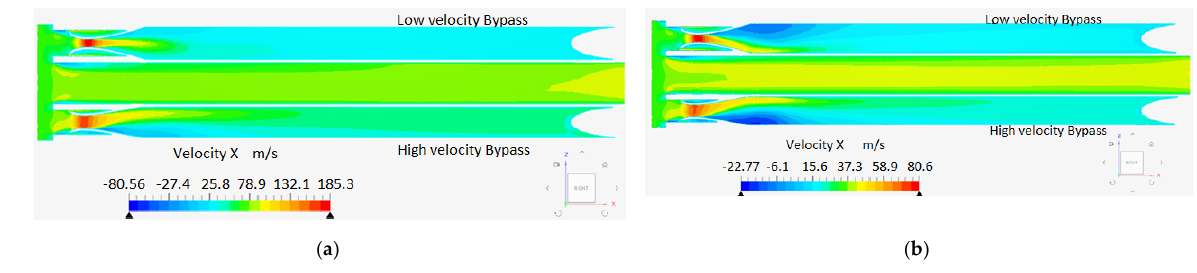
Figure 8. Design geometry simulation results. ( a ) 1000kg/h (14076 SLPM); ( b ) 500kg/h (7038 SLPM).